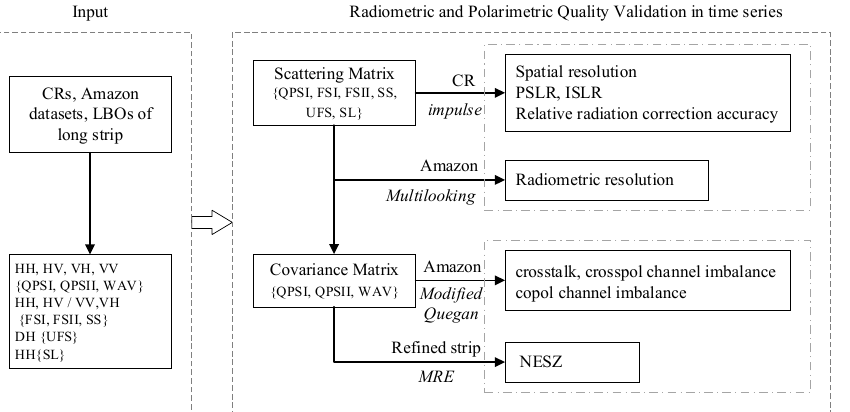
Figure 1. Procedure of the derived CRAS.